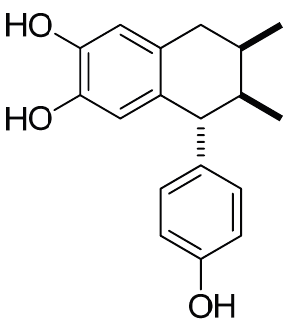
Figure 1. Chemical structure of 3 ′ -demethoxy-6- O